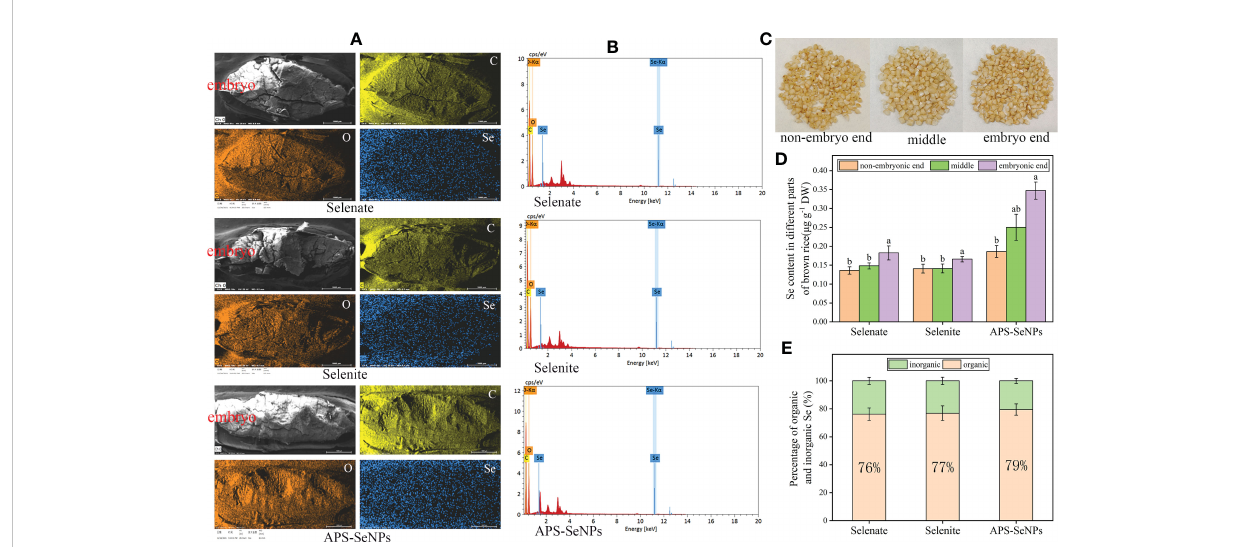
FIGURE 8 Grain selenium (Se) distribution under different Se treatments. (A) X-ray fl uorescence image. (B) Transmission electron microscopy with energy- dispersive X-ray spectroscopy (TEM-EDS). (C) Physical picture of each part of the grain. (D) Se contents of the different parts of rice grain. (E) Organic and inorganic ratios under different treatments. Data are presented as the mean ± SE ( n = 4). Different letters indicate signi fi cant differences between treatments at p < 0.05 according to Duncan ’ s